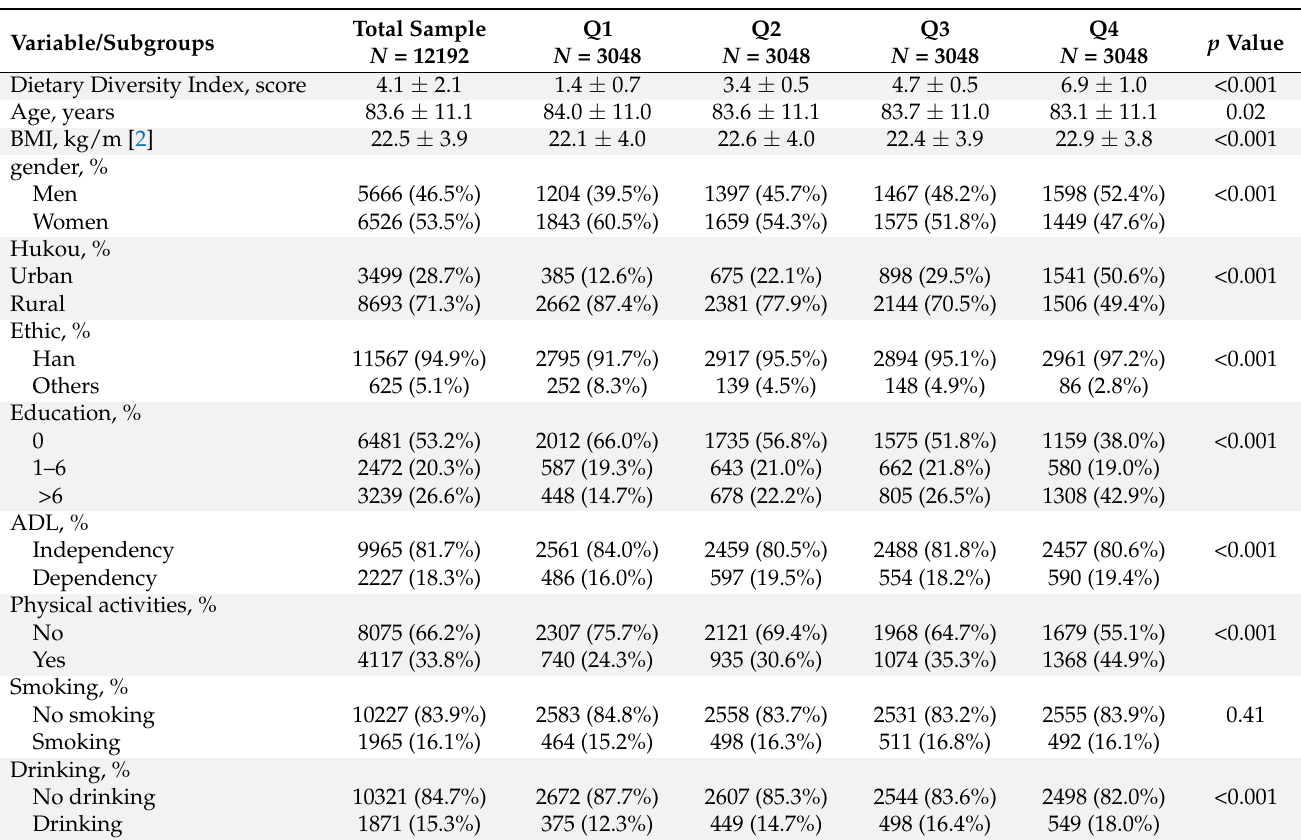
Table 1. Baseline characteristics of the study sample by dietary diversity index (DDI)